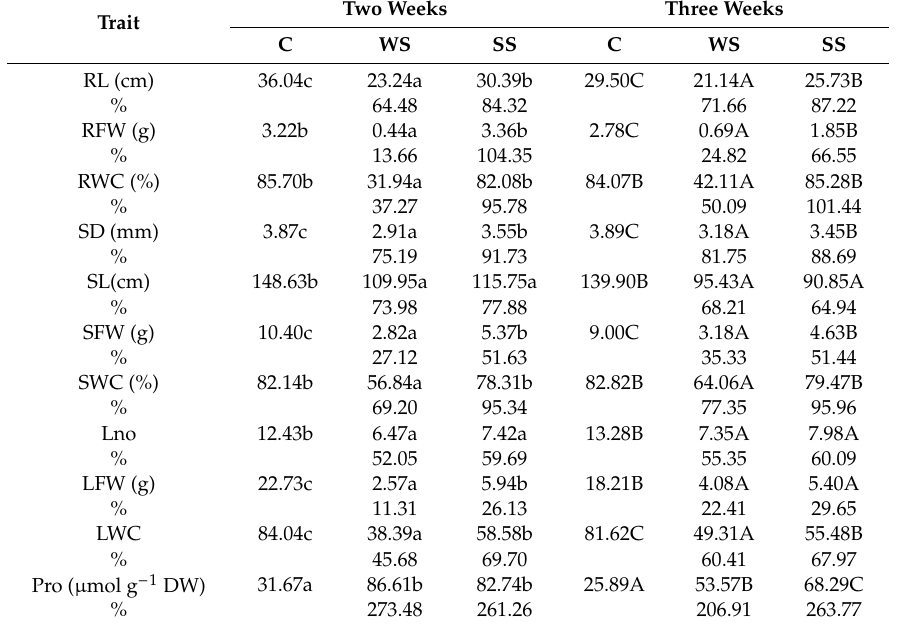
Table 3. Mean values and percentages with respect to the control (%) of traits measured in Phaseolus vulgaris cultivars after two and three weeks of control (C), water stress (WS) (withholding of irrigation) and salt stress (SS) (150 mM NaCl) treatments. Abbreviations: RL, root length; RFW, root fresh